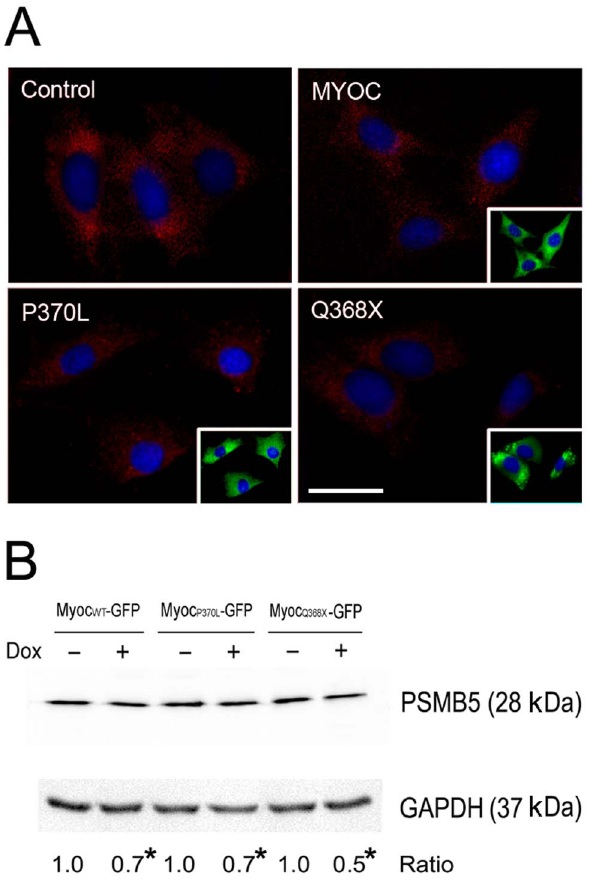
Figure 8. LC3 levels in inducible cells. A . LC3 immunostaining (in red) in inducible, stable RGC5 cells. The cells were induced by Dox for 24 h to express myocilin WT -GFP (MYOC), myocilin P370L -GFP (P370L), or myocilin Q368X -GFP (Q368X). The fusion protein-expressing, green fluorescent cells are shown in insets. There was no green fluorescence, as expected, in non-induced (control) cells. Note an increased LC3 staining intensity in myocilin-GFP-expressing green cells compared with non-induced cells. Scale bar, 10 m m. B . Western blotting for LC3 protein level. RGC5 cells were induced for 24 h to express myocilin WT (Myoc WT )-, myocilin P370L (Myoc P370L )-, or myocilin Q368X (Myoc Q368X )-GFP. Total cell lysate was subject to SDS-PAGE and immunoblotting using anti-LC3 or anti-GAPDH. Both LC3-I and LC3-II protein bands were detected. The LC3/GAPDH ratios in induced cells relative those of non-induced controls are presented. *, P , 0.0046 compared to non-induced controls. All experiments were repeated at least 3 times, yielding similar equation that fitted the curve was used to estimate the half-life of the protein. To investigate the turnover rate of overexpressed myocilin wild- type or mutant (P370L or Q368X)-GFP proteins, Tet-on inducible myocilin-GFP (wild-type, P370L or Q368X)-expressing RGC5 stable cells were plated in 6-well plates and induced 24 h with Dox (1 m g/ml). Cells were washed with phosphate buffered saline three times and incubated in growth medium containing 1% of fetal bovine serum (without Dox). To wild-type myocilin-expressing cells, monesin (2 m M) was also added to block the myocilin secretion. Cells were harvested at various time points and subjected to SDS-PAGE and immunoblotting with anti-myocilin and anti-GAPDH. The level of myocilin-GFP fusion proteins was normalized to that of GAPDH. The ratios were plotted against time points and polynomial equations that fitted the curves were